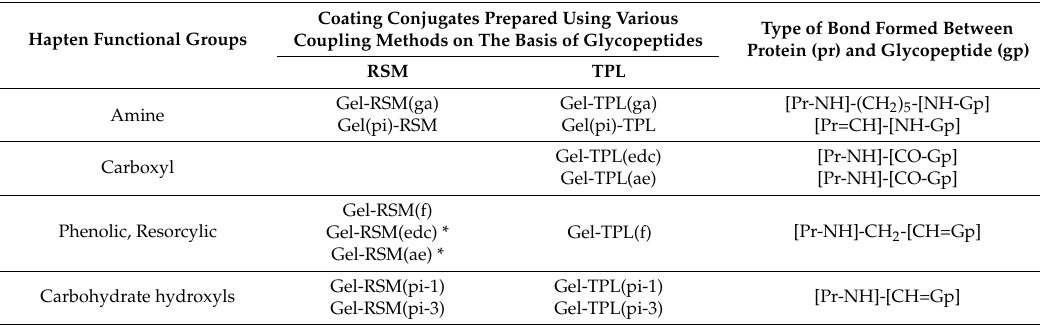
Table 1. Coating conjugates employed in the present